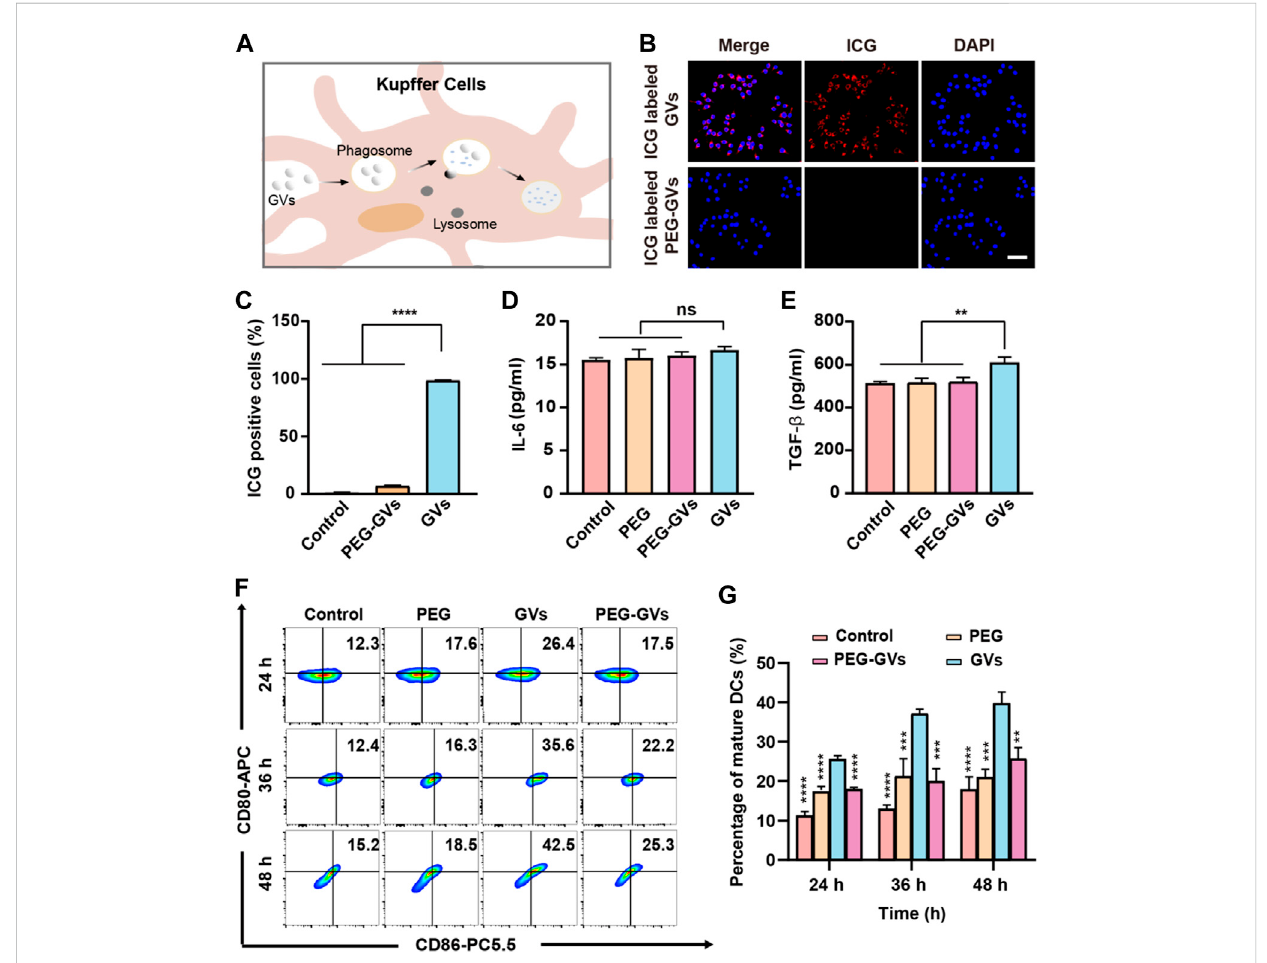
FIGURE 2 In vitro phagocytosis and immunogenicity tests. (A) Schematic diagram of phagocytosis of GVs by mouse hepatic macrophages; (B) Confocal microscopy images of RAW264.7 macrophages incubated with ICG-labeled GVs and ICG-labeled PEG-GVs for 6 h (scale bar = 50 μ m); (C) fl ow cytometry analysis of RAW264.7 macrophages incubated with ICG-labeled GVs and ICG-labeled PEG-GVs for 6 h; (D – E) ELISA assay of the secretion of IL-6 (D) and TGF- β (E) by DC 2.4 dendritic cells incubated with PEGs, GVs or PEG-GVs for 24 h. Error bars represent ± SD. ns, no statistical signi fi cance. (F) Flow cytometry analysis of DC 2.4 dendritic cells incubated with PEGs, GVs or PEG-GVs for 24, 36 or 48 h (G) the corresponding quanti fi cation of fl ow cytometry. Error bars represent ± SD ( **p < 0.01, ***p < 0.001,****p < 0.0001 )